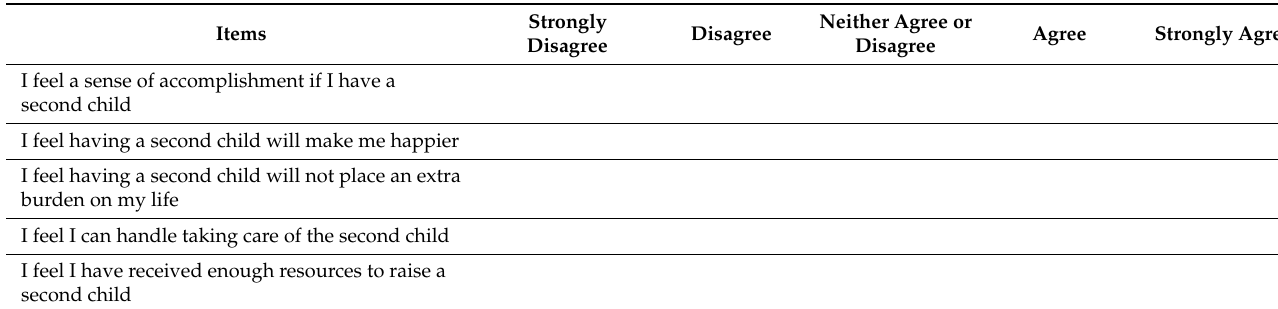
Table A4. Second-child fertility intention